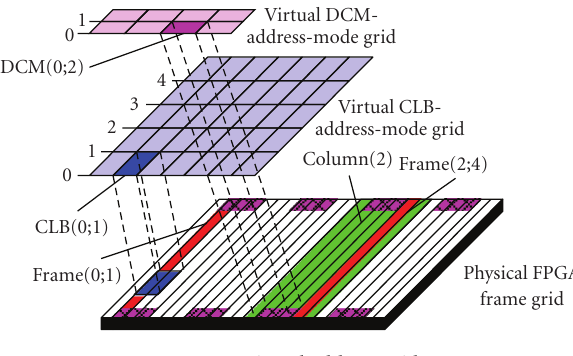
Figure 6: Virtual address